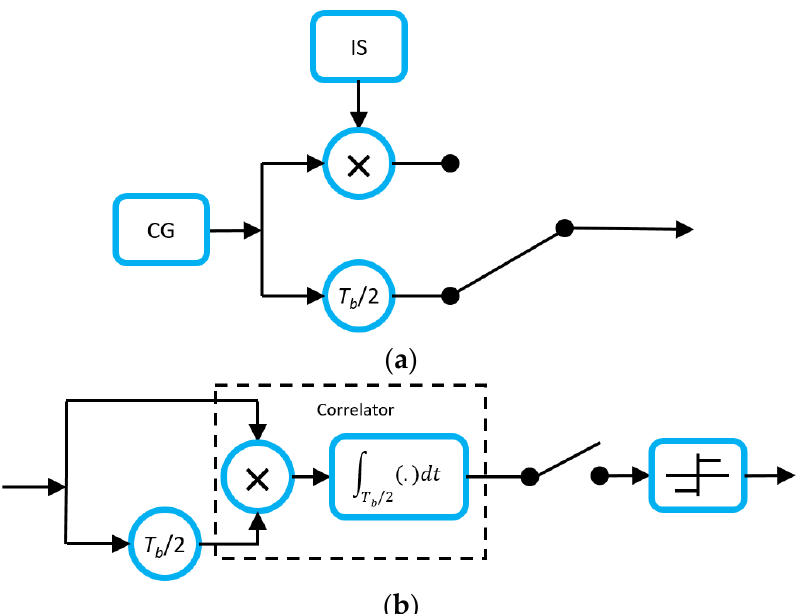
Figure 2. DCSK scheme: ( a ) transceiver, CG—chaos generator, IS—information sequence, T b —bit time; ( b ) receiver, where T b —bit time.